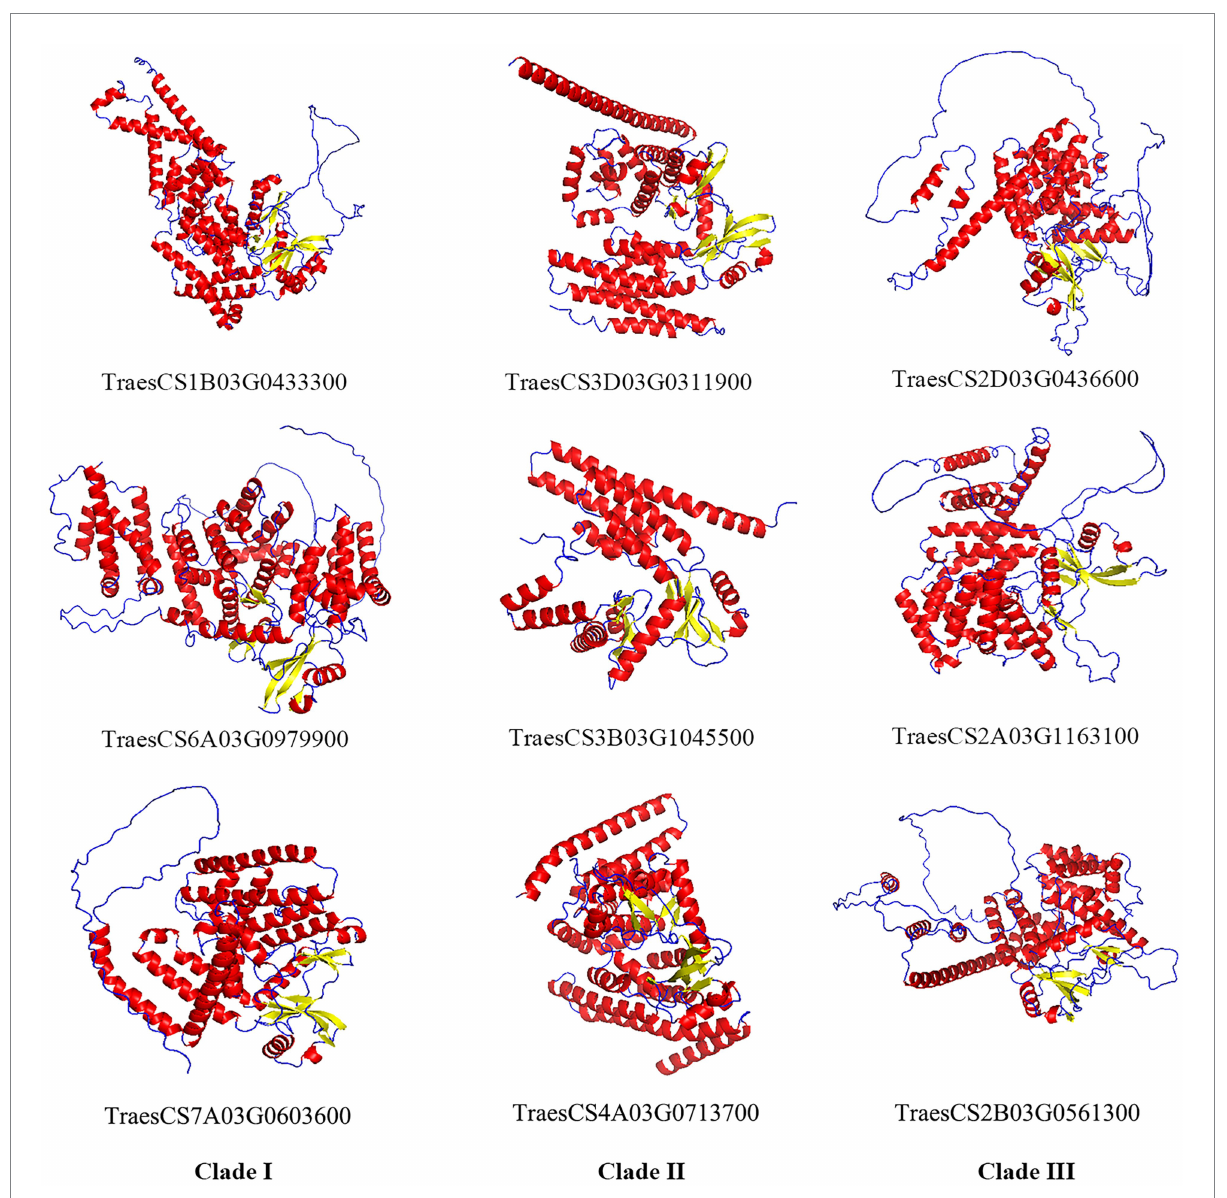
FIGURE 3 Three-dimensional structures of nine TaABC1K proteins from three different clades predicted by AlphaFold2. Red, α -helix; Blue, random coil; Yellow, β